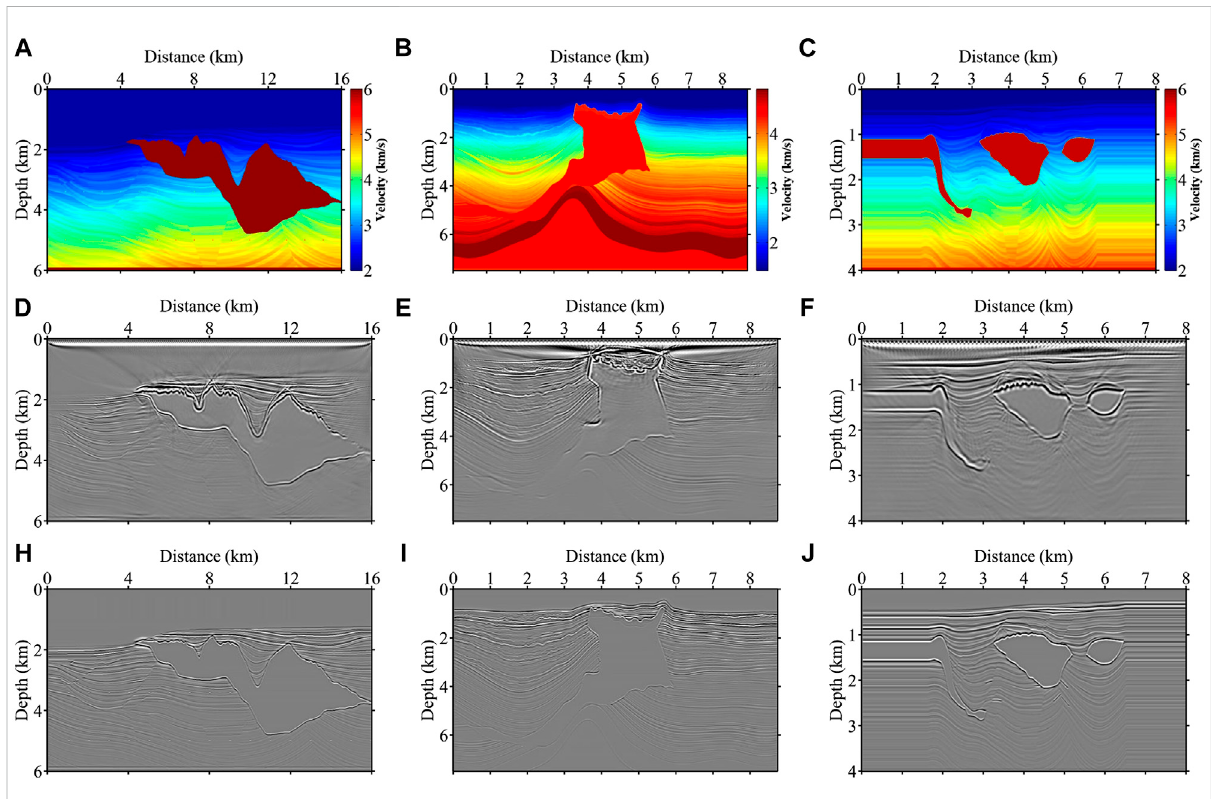
FIGURE 4 Threevelocitymodelsforproducingtrainingdatasetsinthesourceandtargetdomains. (A) Sigsbee2Avelocitymodel, (B) SEAMvelocitymodel, and (C) Pluto velocity model. The corresponding RTM imaging results (D – F) and re fl ectivity models (H – J) for making the input and output samples